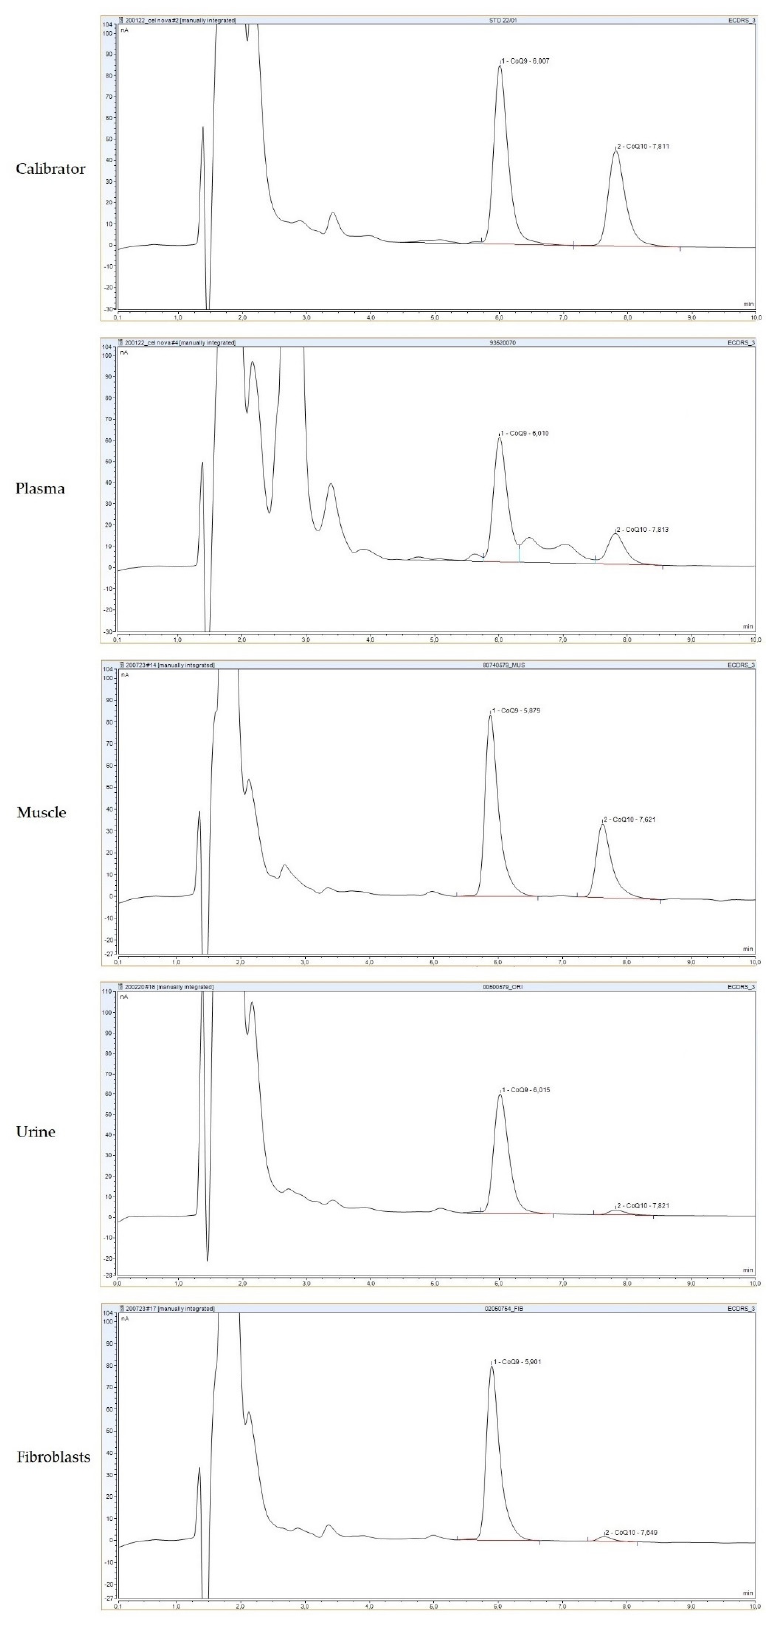
Figure 2. Typical chromatograms of CoQ determination by high-performance liquid chromatogra- phy with electrochemical detection (HPLC-ED) in different specimens: calibrator, plasma, muscle homogenate, urine and skin fibroblasts. CoQ 9 was used as the internal